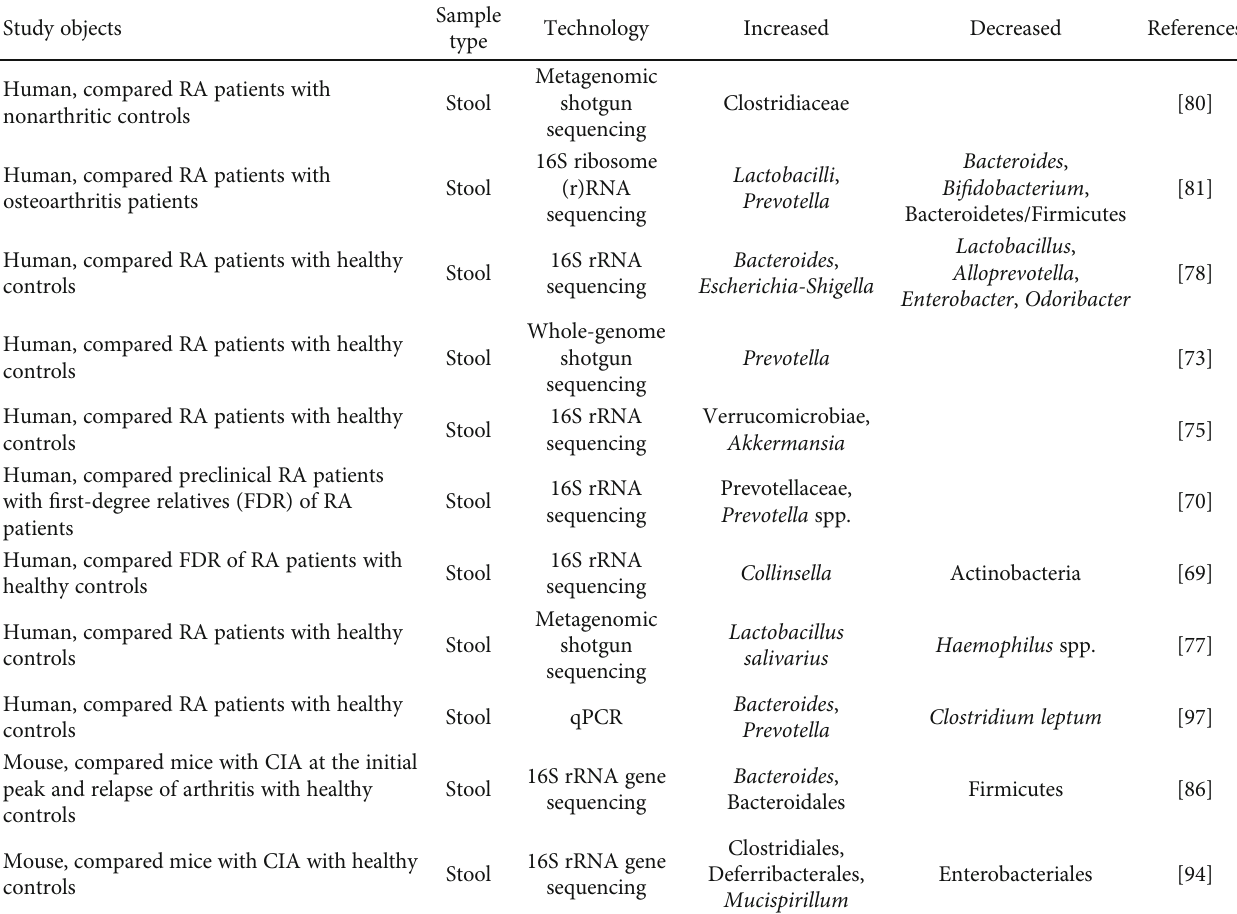
Table 1: The alteration of the gut microbiota in RA patients and animal